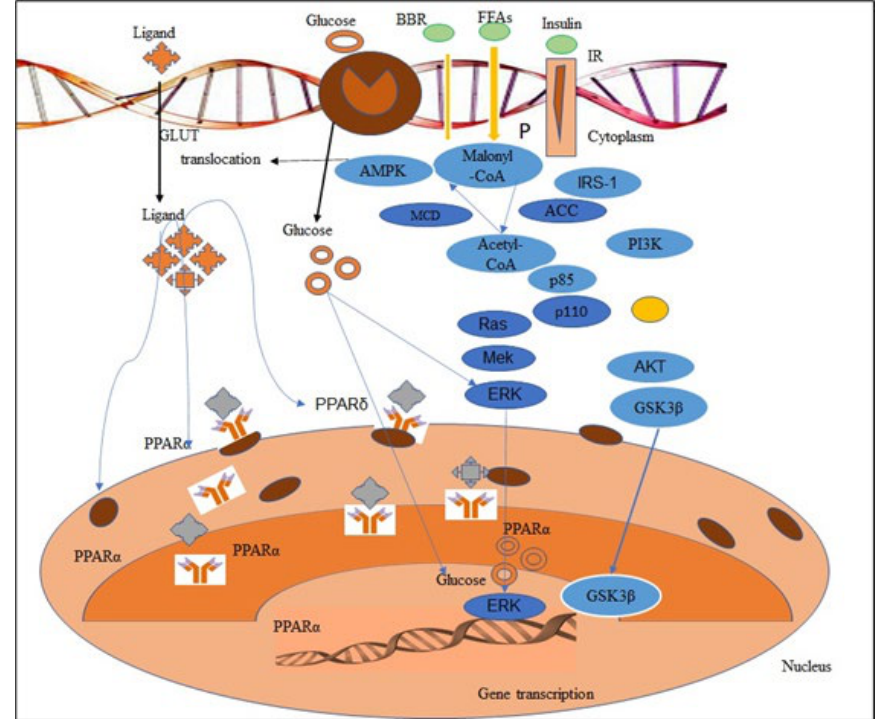
Fig. 1. Signaling Pathway participate in the